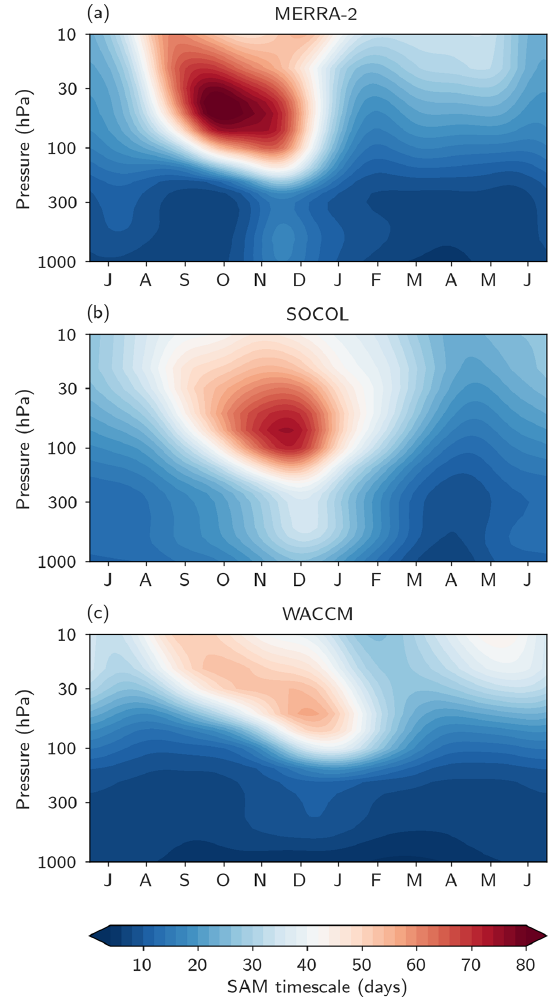
Figure 8. The SAM timescale τ (in days) as a function of sea- son and height in the reanalysis MERRA-2 (a) and the models SO- COL (b) and WACCM (c)